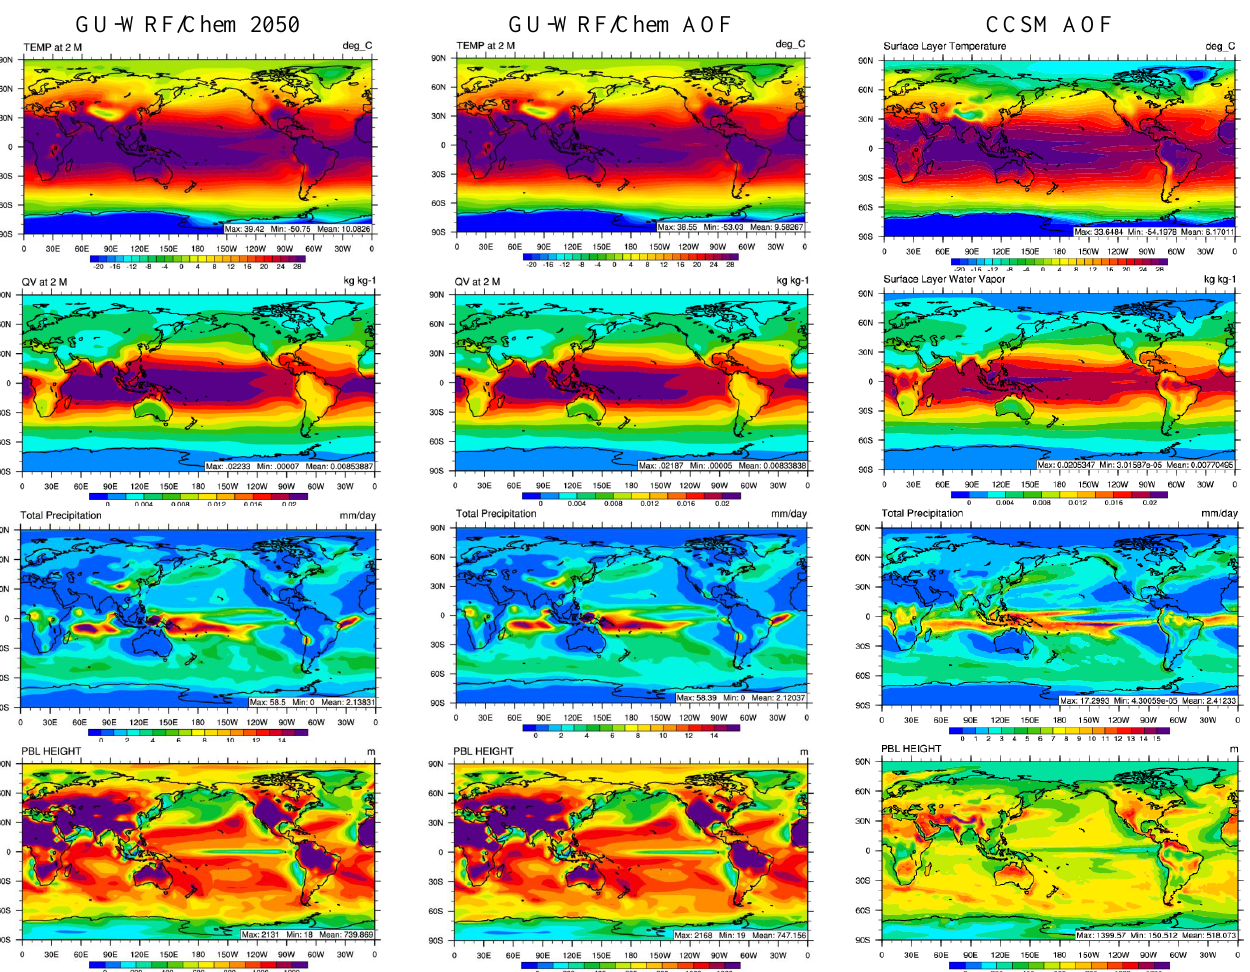
Figure 2. Average spring (MAM) 2-m temperature, 2-m water vapor, precipitation rate, and planetary boundary layer height fields from GU-WRF/Chem simulations of the year 2050 (left), averaged future period consisting of 2020, 2030, 2040, and 2050 (AOF) (center), and the average of the future period 2015-2054 from CCSM3 initial conditions (right).